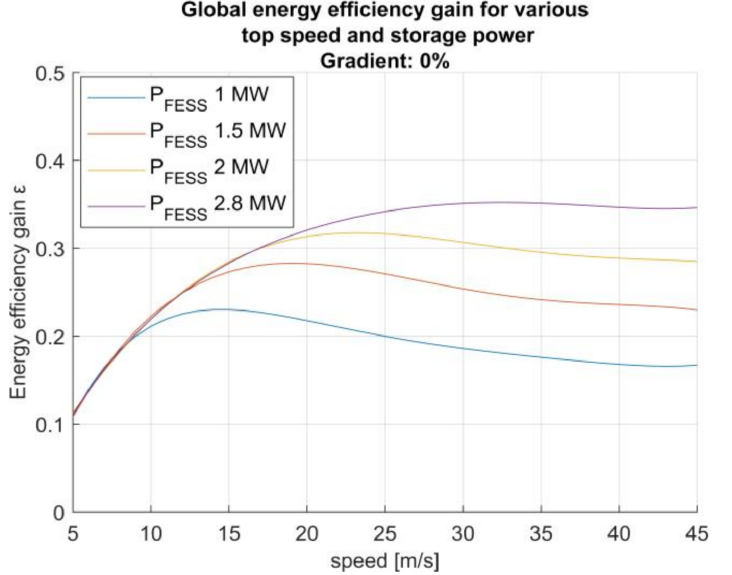
Figure 7. No gradient efficiency gain for multiple top speeds and FESS